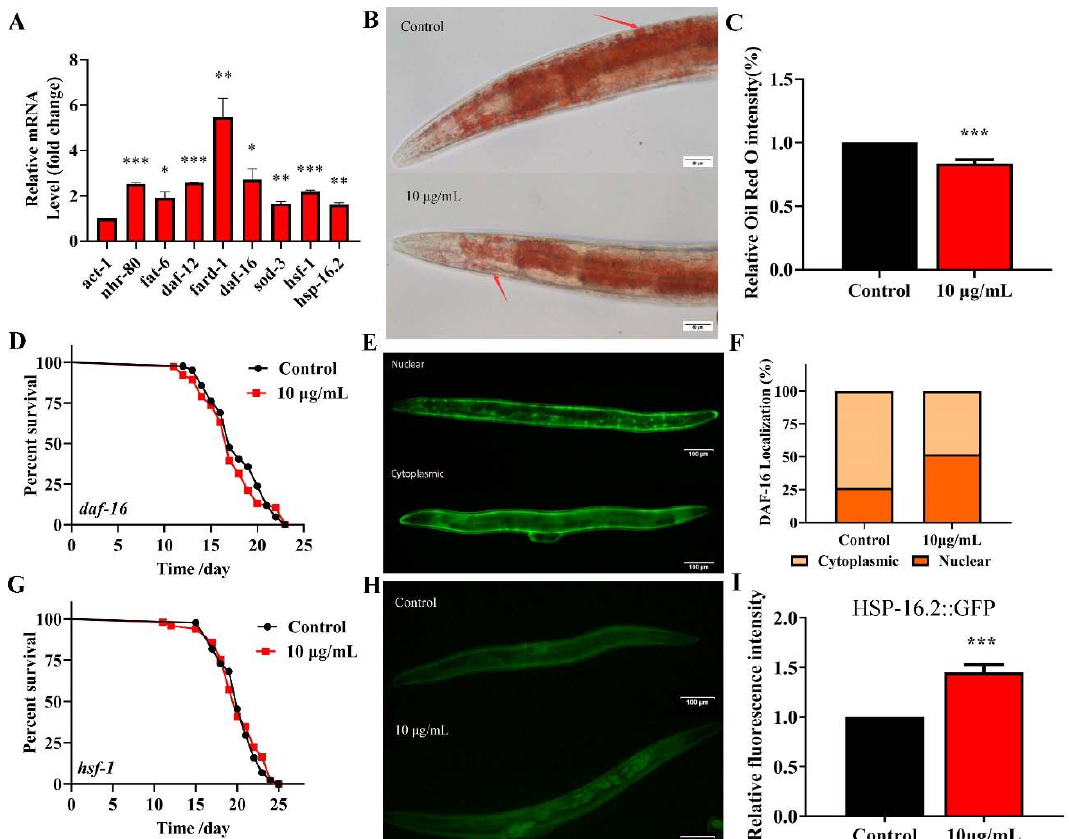
Figure 8. TG reduces the fat accumulation and increases the expression of nhr-80 , daf-12 , daf-16 and hsf-1 in C. elegans . ( A ) TG enhances the expression of nhr-80 , fat-6 , daf-12 , fard-1 , daf-16 , sod-3 , hsf-1 and hsp-16.2 . ( B , C ) The fat content in C. elegans treated with or without TG. The worms were stained with oil red O. TG significantly reduced the fat content in C. elegans . ( D ) The mean lifespan of daf-16 (mgDf50) treated with or without TG. TG could not extend the lifespan of daf-16 (mgDf50) . ( E , F ) DAF-16::GFP expression in TG-treated worms. ( G ) The mean lifespan of hsf-1 (sy441) with or without TG. TG failed to extend the lifespan of hsf-1 (sy441) . ( H , I ). The quantification of HSP-16.2::GFP fluorescence in the presence or absence of TG. TG significantly increases the expression of HSP-16.2 in C. elegans . The data were analyzed using a Student’s t-test. The values were shown as the mean ± SEM, *** p < 0.001, ** p < 0.01, * p < 0.05.